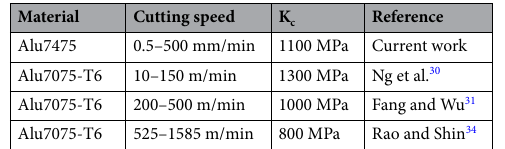
Table 1. Comparison of the values of the Kc.